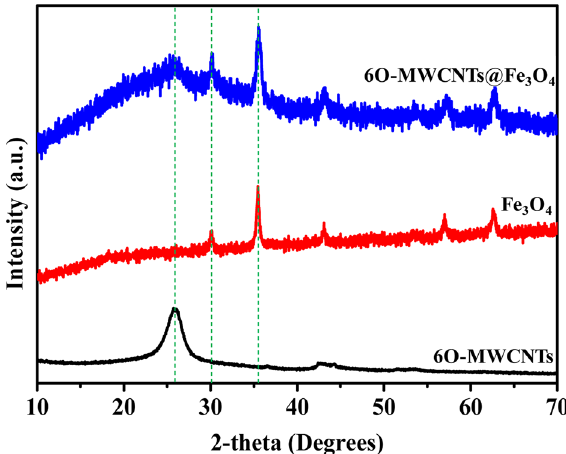
Figure 1. XRD patterns of 6O-MWCNTs, Fe 3 O 4 and 6O-MWCNTs@Fe 3 O 4